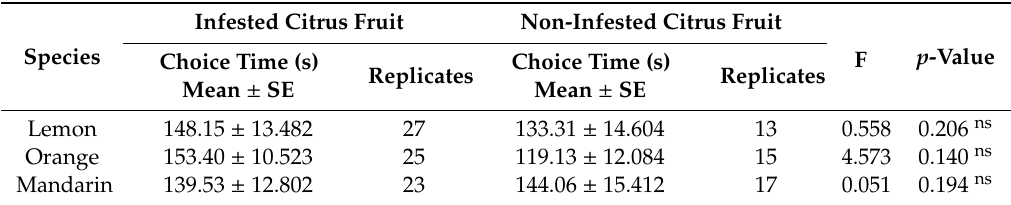
Table 2. Choice time spent by Aphytis melinus females during searching behaviour on non-infested and Aonidiella aurantii -infested citrus fruits in Y-tube Olfactometry. Infested Citrus Species